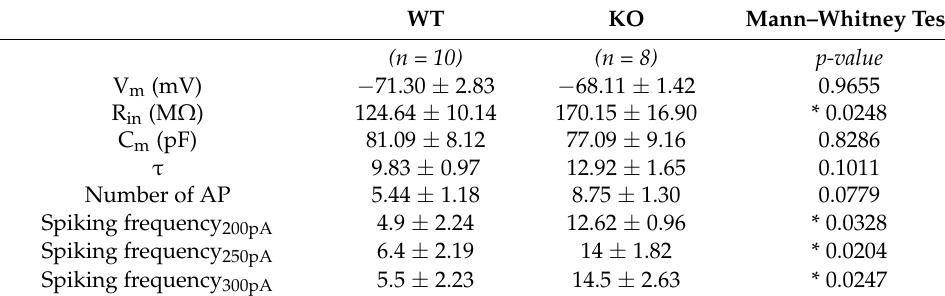
Table 1. Intrinsic passive properties of hippocampal neurons. WT KO Mann–Whitney Test (n =